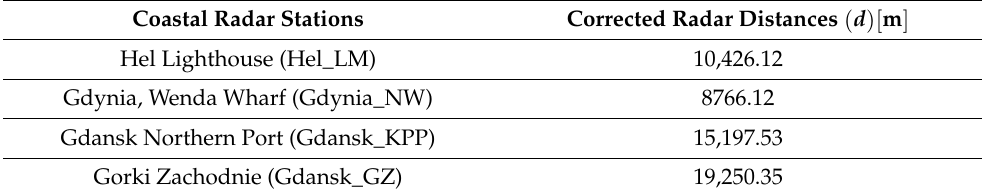
Table 4. Corrected radar distances from coastal radar stations to the